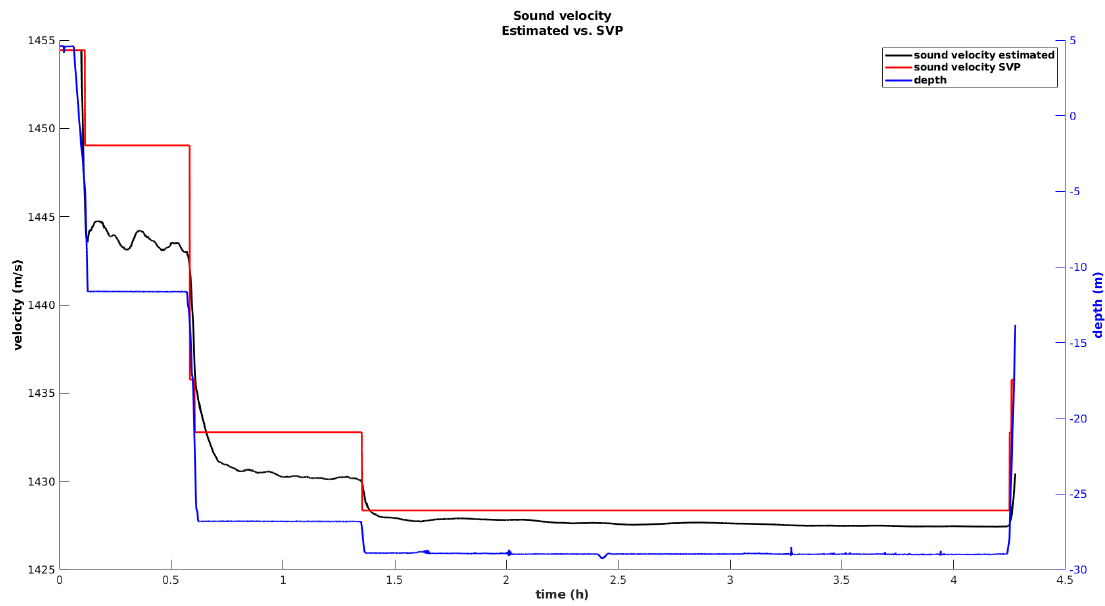
Figure 11. Comparison between the estimated sound velocity estimated and the SVP measurements along the water column.